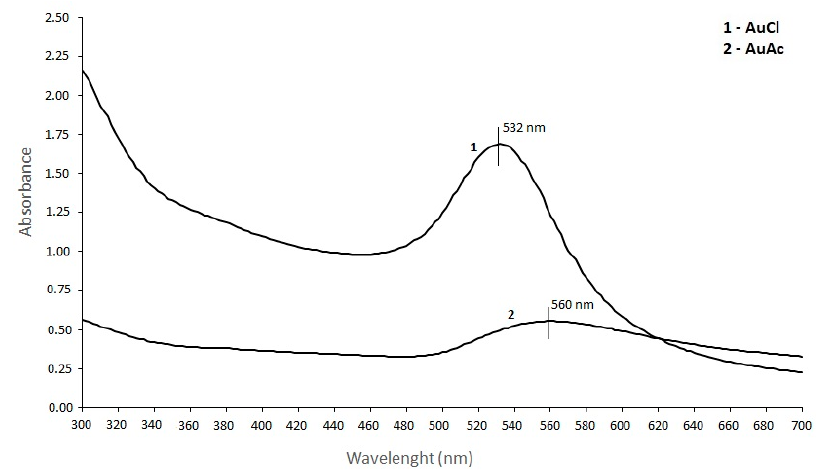
Figure 4. Absorbance spectra of AuNPs from gold chloride and gold acetate.